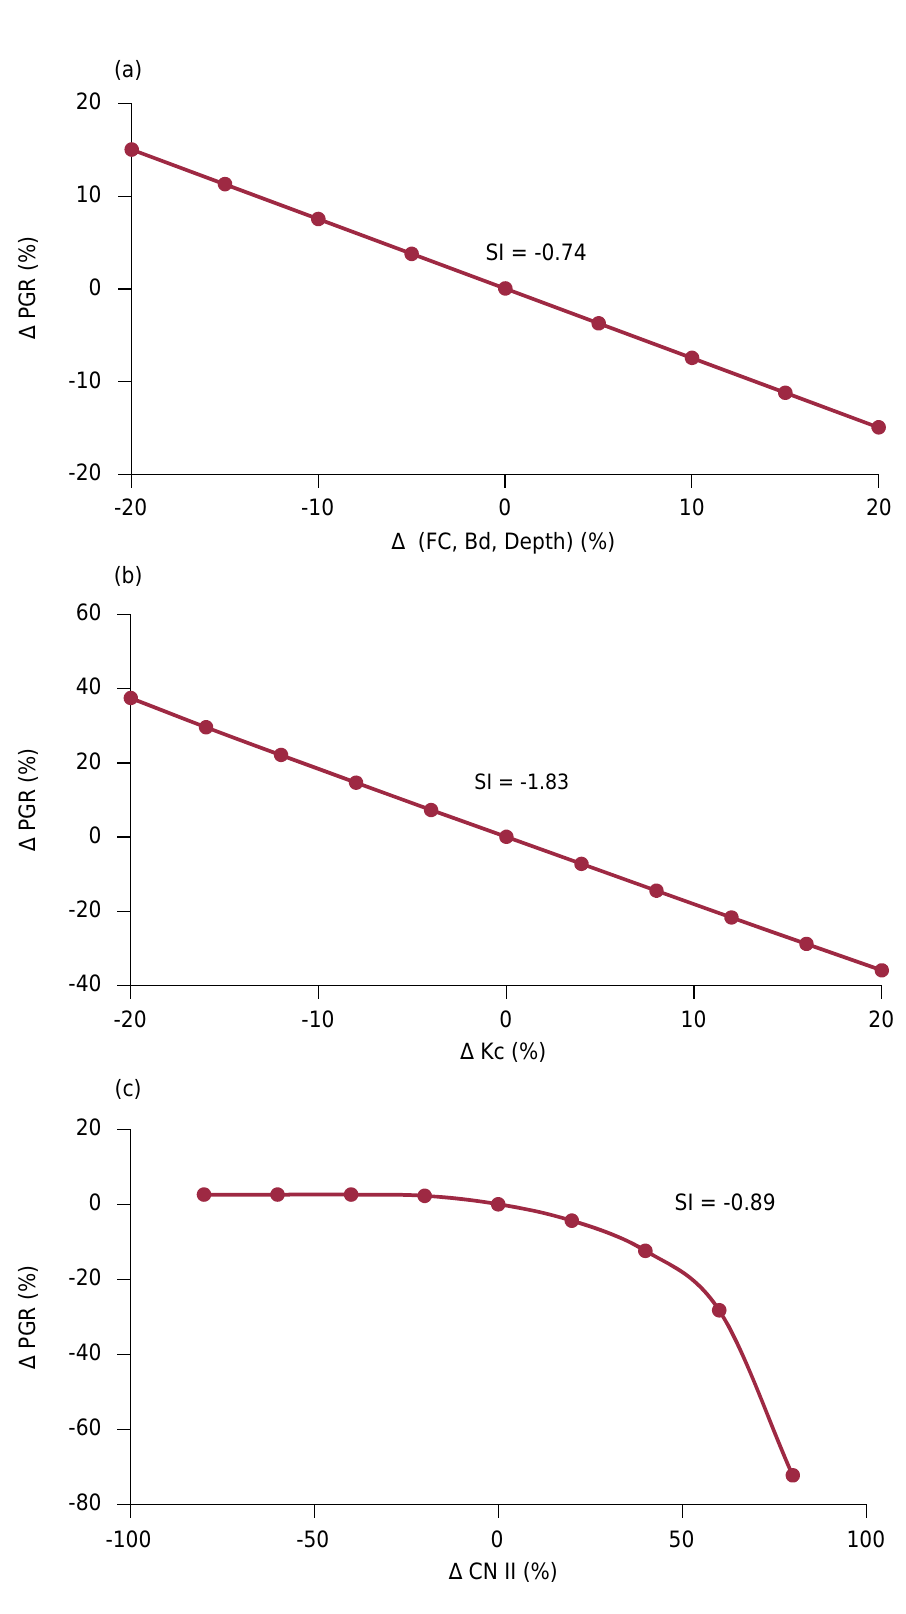
Figure 4. Variation in groundwater recharge due to the BALSEQ model parameters (a) field capacity, soil bulk density, and effective depth of the root system; (b) crop coefficient; and (c) curve